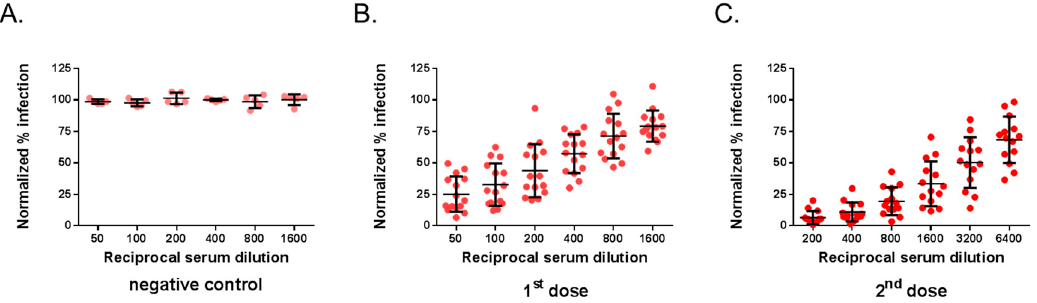
Figure 3. Flow cytometry neutralization test on Vero cells. The neutralizing ability of mouse serum specimens against ZIKV was determined by flow cytometry neutralization test (FNT) on Vero cells. Samples of anti-ZIKBeHMR-2 immune sera were tested individually. Serum specimens were two-fold serial diluted starting at a 1:50 dilution and mixed with an equal volume of virus sample containing 20,000 PFU of MR766 GFP . The virus-antibody mixture was added on 20,000 Vero cells grown in 96-well plates. At 20 h post-infection, the percentage of positive cells for GFP expression was determined by flow-cytometry analysis. The number of GFP-positive cells without serum was considered 100% of infectivity. The results were expressed as the percentage of GFP-positive cells in assay relative to that calculated in absence of serum. In ( A ), the immune sera of BALB / c mice inoculated with heat-inactivated ZIKBeHMR-2 served as a negative control (negative control). In ( B ), immune sera of BALB / c mice that received a single dose of ZIKBeHMR-2 (5 log PFU) (1 st dose). In ( C ), immune sera of BALB / c mice that received two doses of ZIKBeHMR-2 (5 log PFU) with a 6-week interval (2 nd dose). Data fitting between PRNT 50 and FNT 50 values on anti-ZIKBeHMR-2 immune sera revealed a